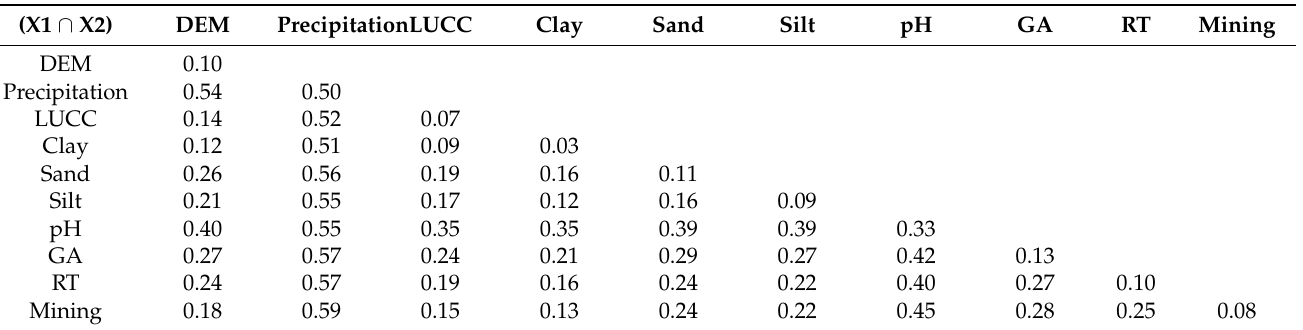
Table 9. Effects of the interaction between each pair of driving factors on the enrichment of the Zn concentration in the